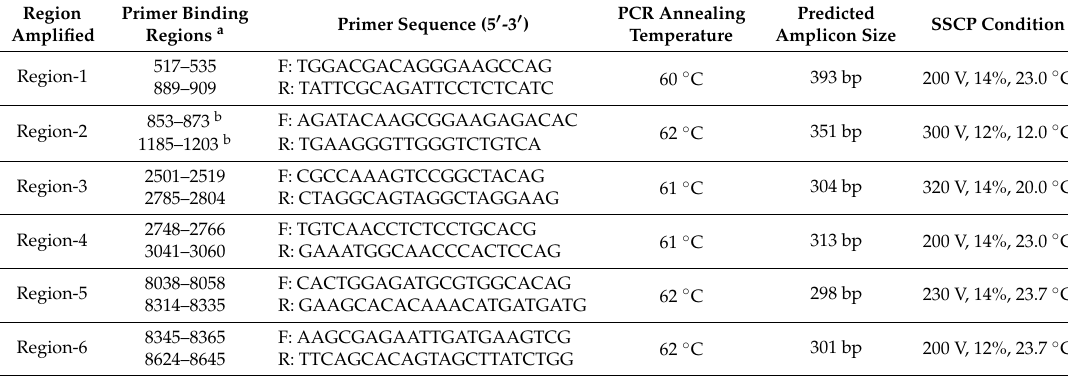
Table 1. The primer sequences and single-stranded conformational polymorphism (SSCP) conditions for the analysis of regions of ovine uncoupling protein-1 gene ( UCP1 ). Region